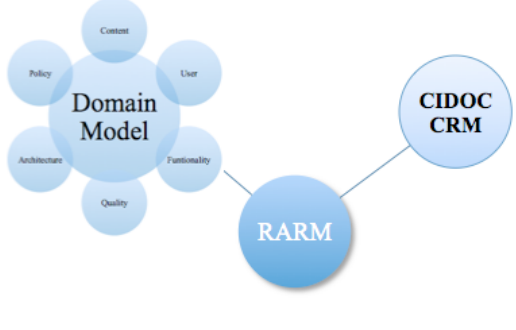
Figure 4. The RADB